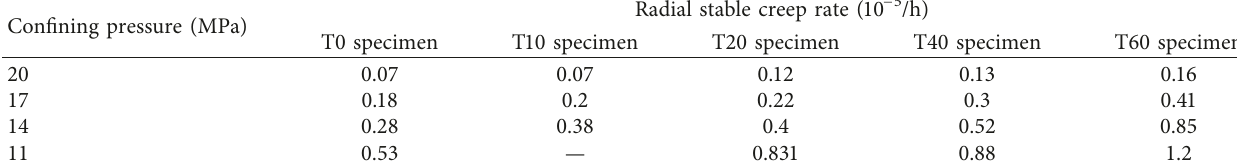
Table 5: Radial stable creep